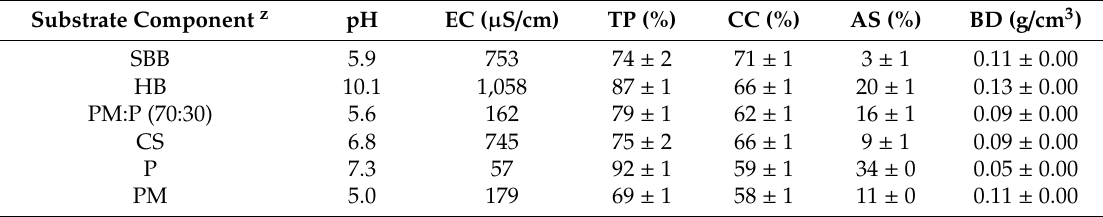
Table 1. The pH, electrical conductbity (EC), total porosity (TP), container capacity (CC), air space (AS) and bulk density (BD) of substrate components used in this